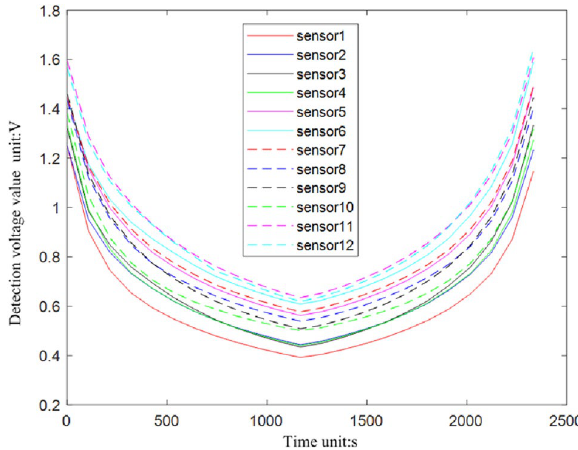
Figure 11. Sensor suitability test results.